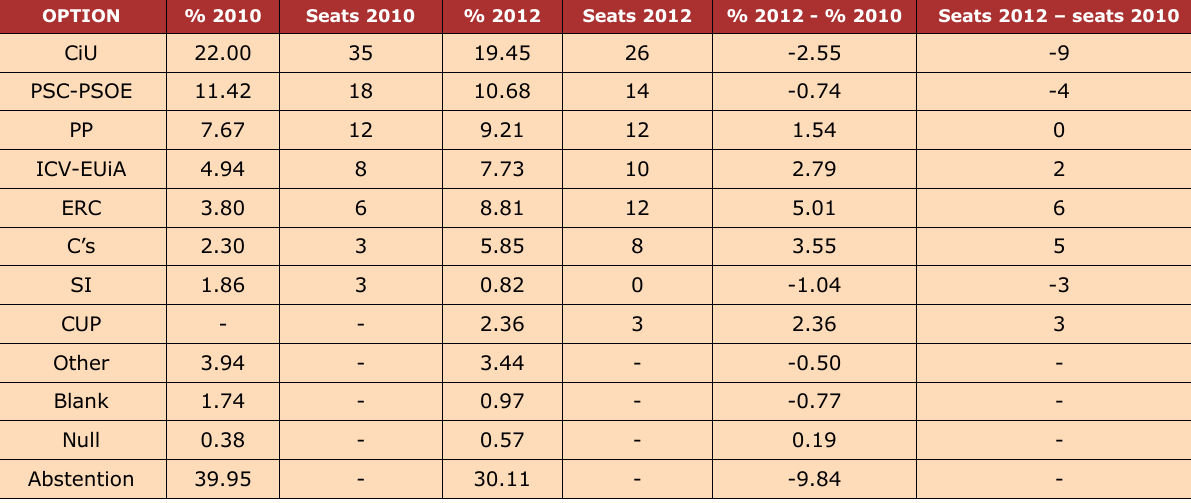
Table 4. Main results, in the constituency of Barcelona, of the elections to the Catalan Parliament held in 2010 and